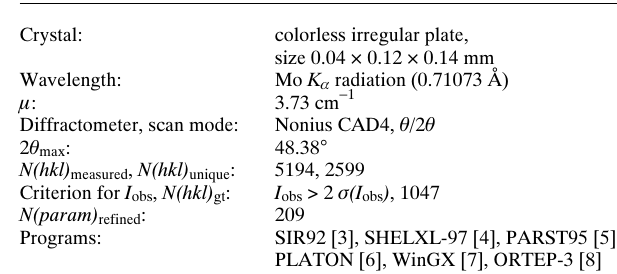
Table 1. Data collection and